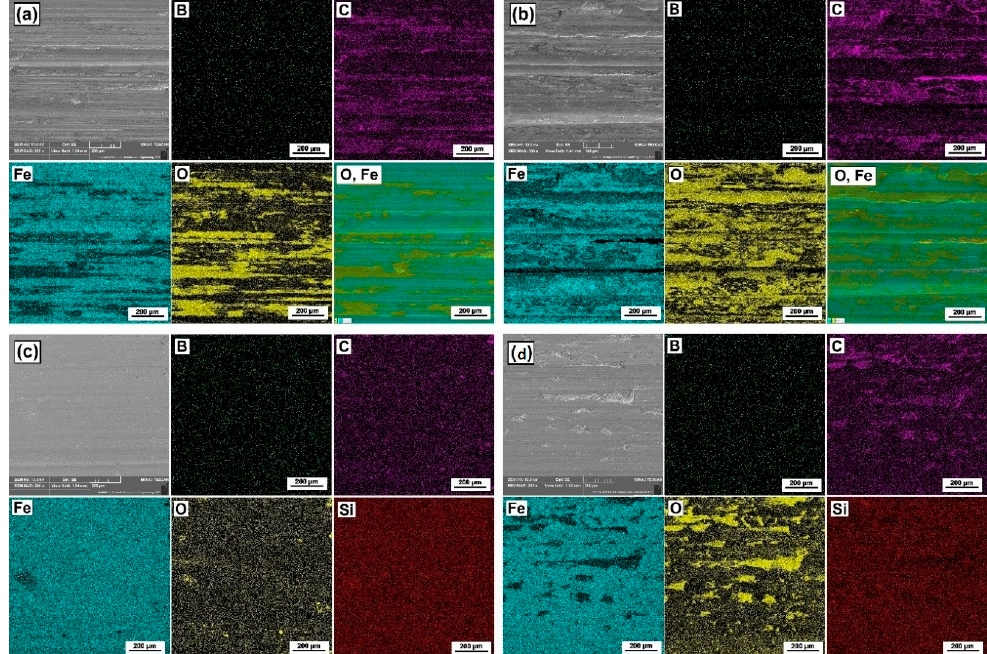
Figure 13. Surface conditions after wear resistance tests: ( a ) Fe–B coating (#1 laser beam